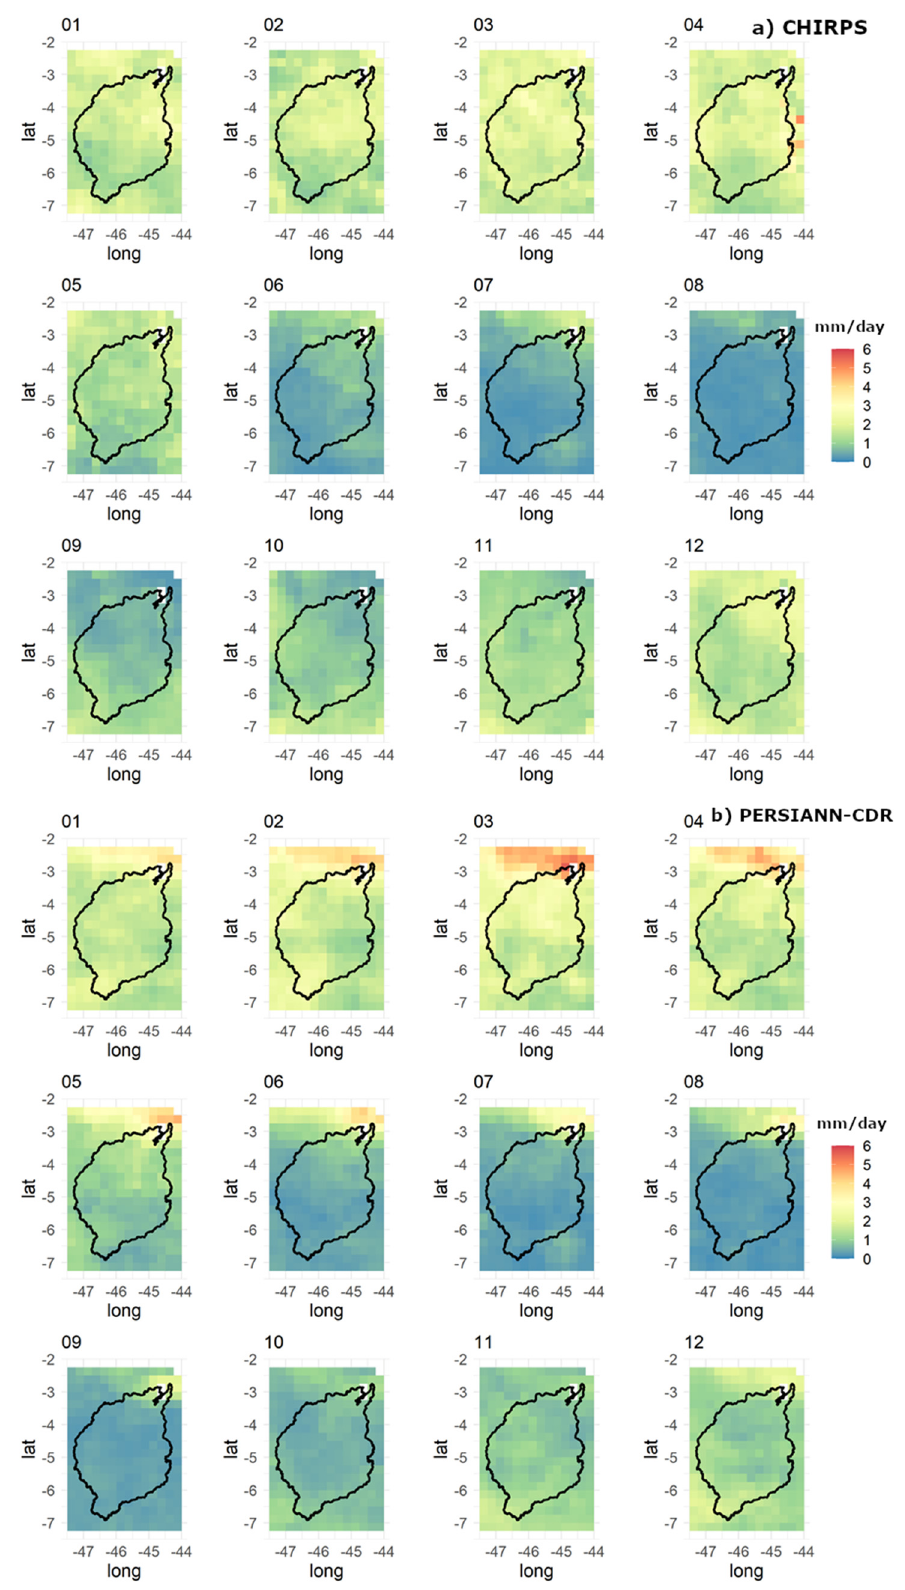
Figure 7. RMSE (mm/day) monthly mean (gridBR × CHIRPS ( a ) and gridBR × PERSIANN-CDR ( b )) from January (01) to December (12) 1983 to 2013.